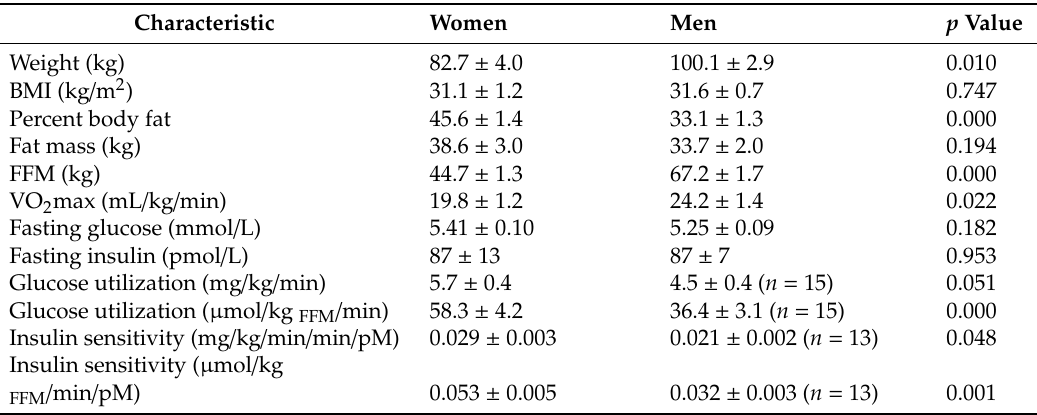
Table 2. Comparison of physical and metabolic characteristics and gene expression between men ( n = 18) and women ( n = 17) before the intervention.